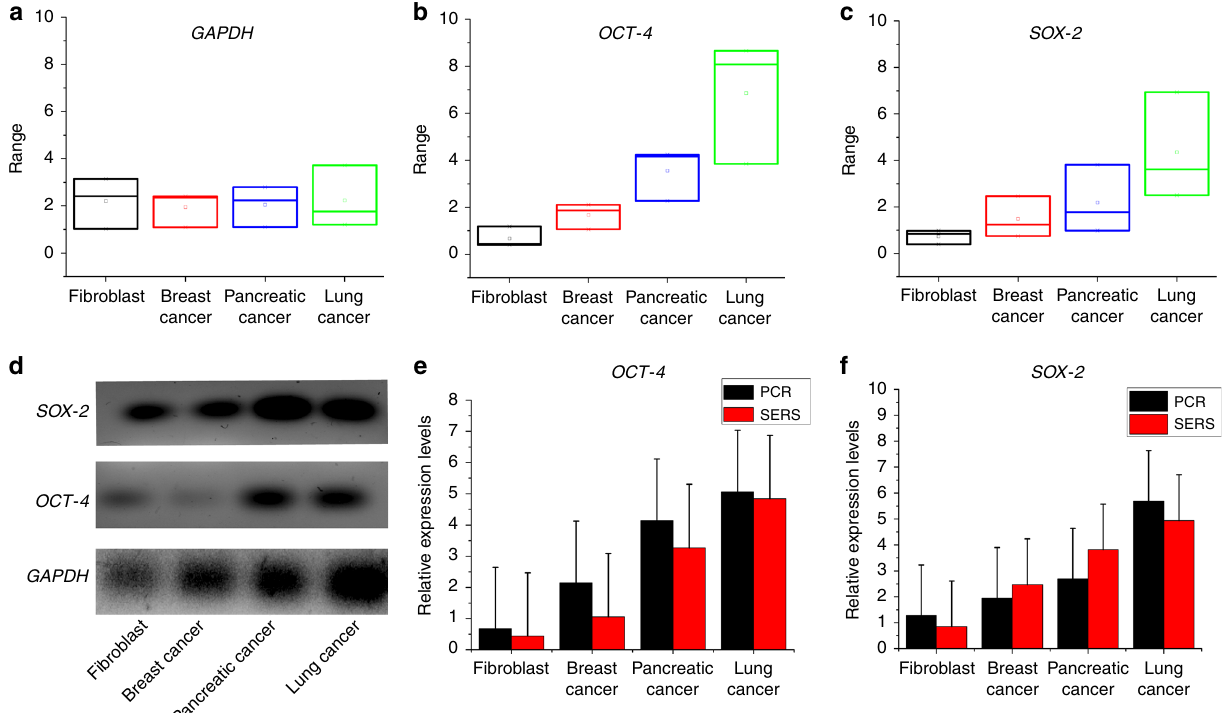
Fig. 9 Validation of gene expression analysis by semiquantitative PCR. a – c expression levels of GAPDH OCT-4 and SOX-2 in box plots, respectively. d Semiquantitative PCR to validate relative expression levels of OCT-4 and SOX-2 in comparison with GAPDH, e , f comparative data between relative gene expressions obtained from PCR and SERS using tag-free